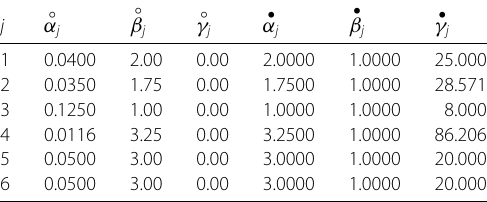
Table 1 The parameter values used in this